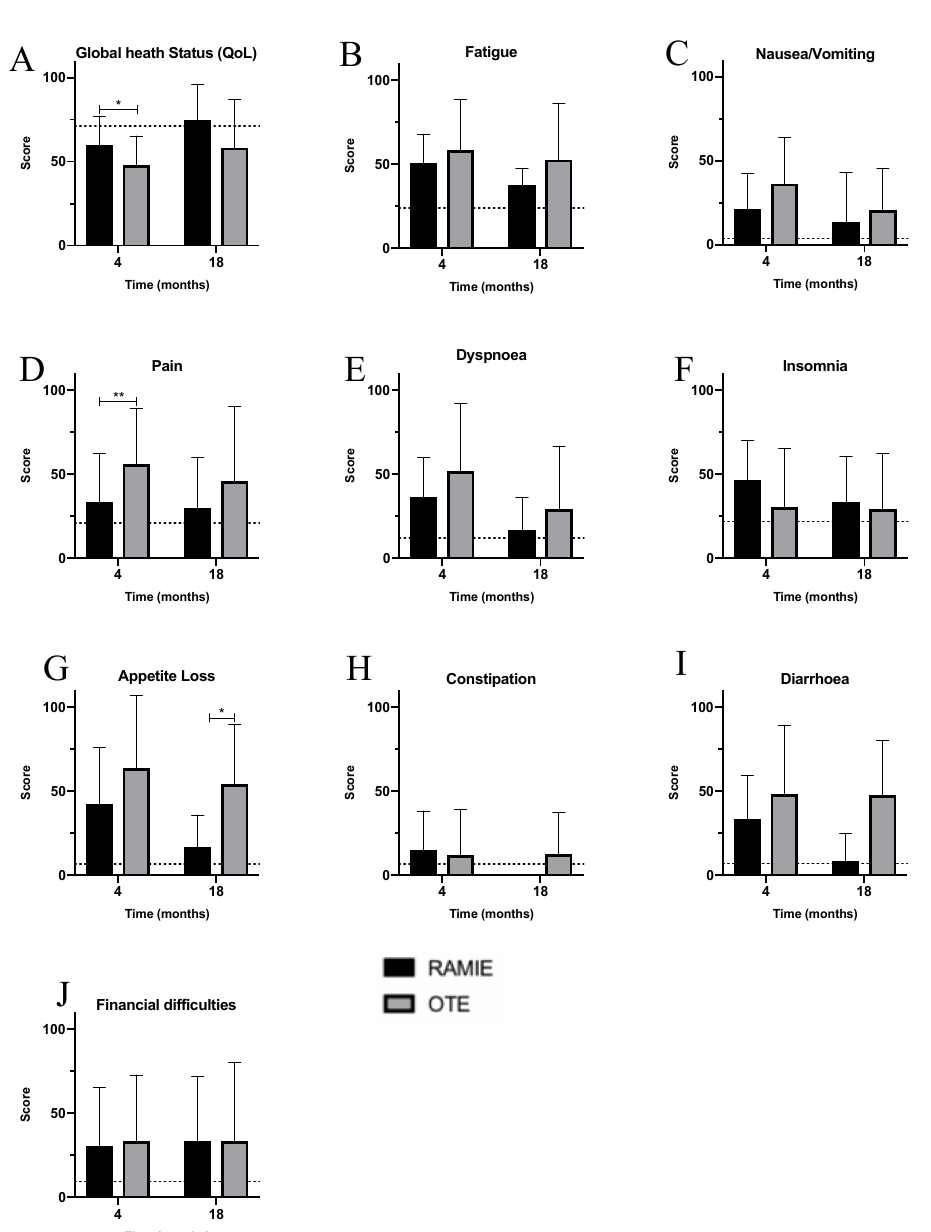
Figure 5. Quality of life and symptoms in the propensity score matching (PSM) analysis stratified by cohorts—RAMIE (black) vs. OTE (grey). ( A ) Global health status; ( B ) fatigue; ( C ) nausea/vomiting; ( D ) pain; ( E ) dyspnea; ( F ) insomnia; ( G ) appetite loss; ( H ) constipation; ( I ) diarrhea; and ( J ) financial difficulties. OTE: open transthoracic esophagectomy; RAMIE: robot-assisted minimally-invasive esophagectomy.